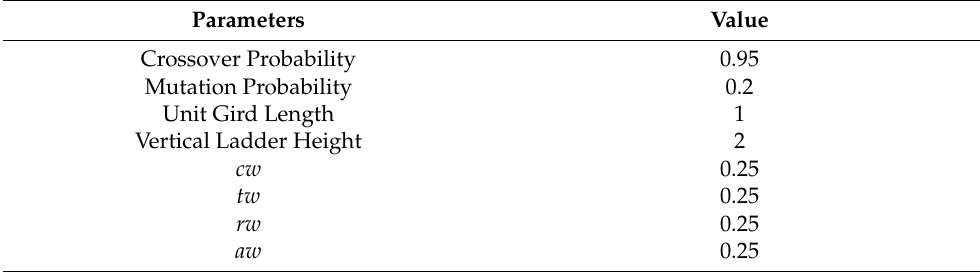
Figure 13. Results of artificial potential field test (with 30 × 30 grid map): ( a ) MLRMOEGA path (Falling risk: 0.70868); ( b ) SGA path (Falling risk: 0.7137). Table 5. Other parameters of the proposed